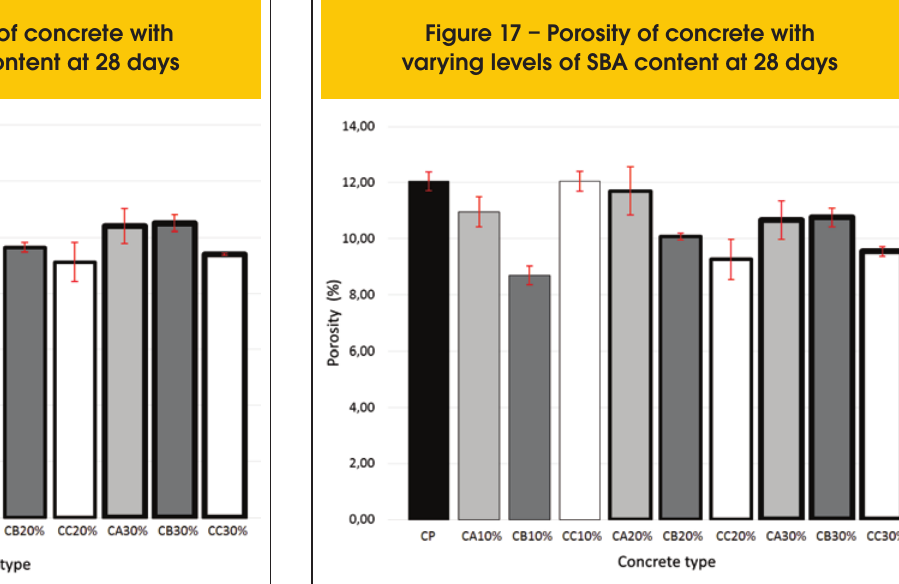
Figure 17 – Porosity of concrete with varying levels of SBA content at 28